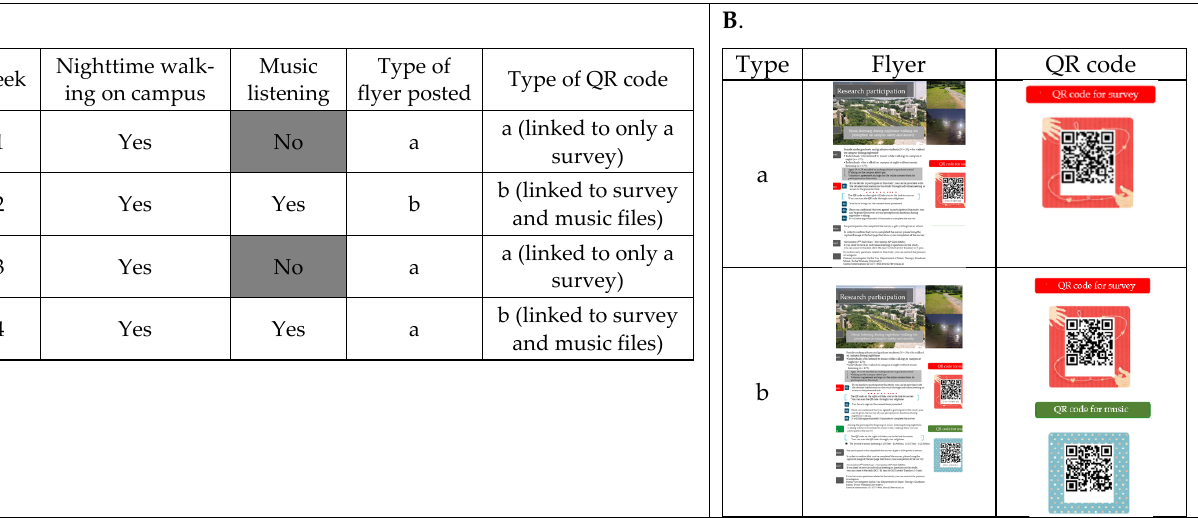
Figure 1. The outline of procedures. Panel ( A ) indicates the condition of nighttime walking on campus and the type of flyers used. Panel ( B ) shows the flyers that were posted and the QR codes that were embedded in the flyer.